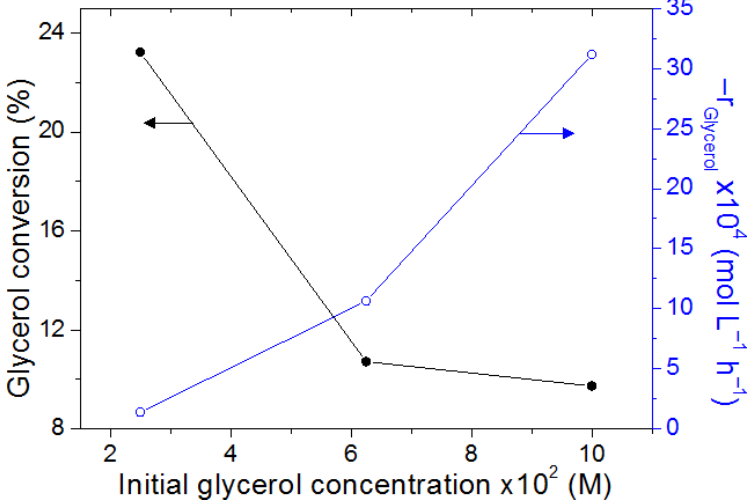
Figure 12. Effect of initial glycerol concentration on the glycerol conversion and initial reaction rate (T = 305.65 K, Cu/TiO 2 = 0.25 g/L).